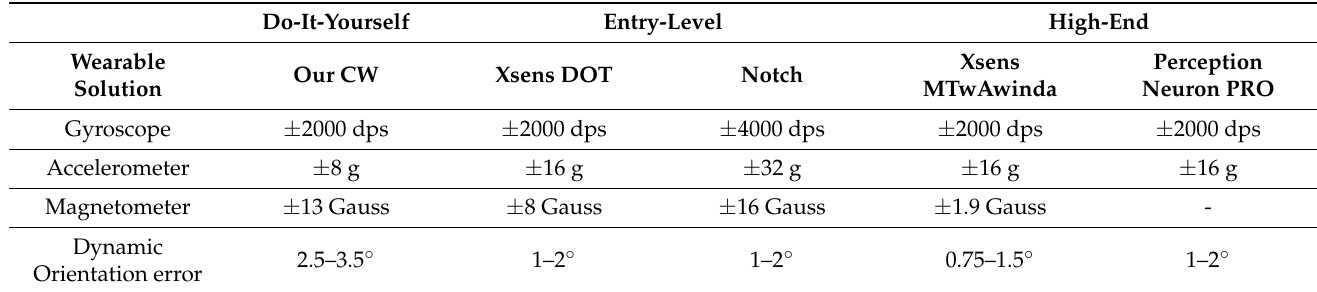
Table 1. Features of internal IMU sensors of the proposed system and other commercial